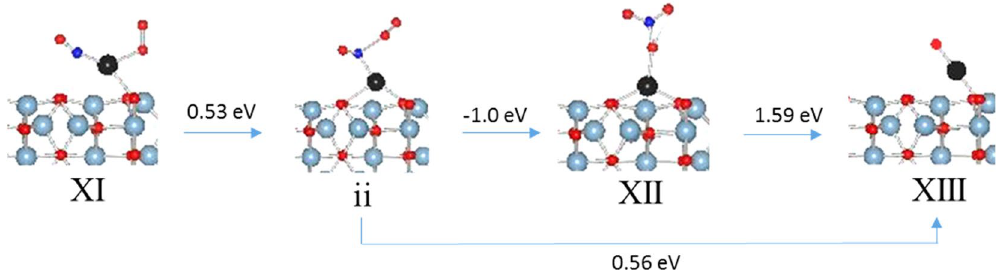
Figure 10. Energetics of NO 2